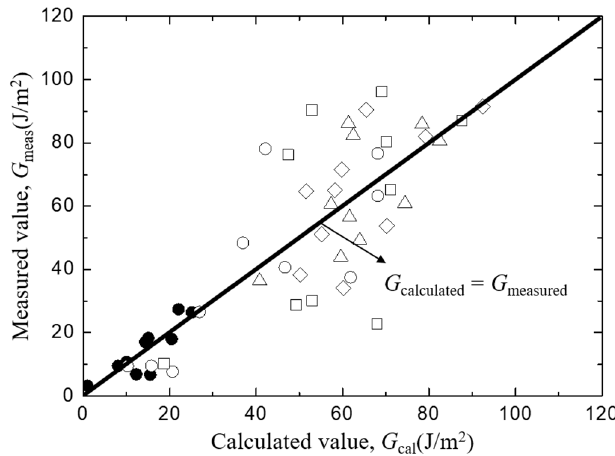
Figure 7. The comparison between measured and calculated interfacial facture toughness of Typha spp. /PLLA.